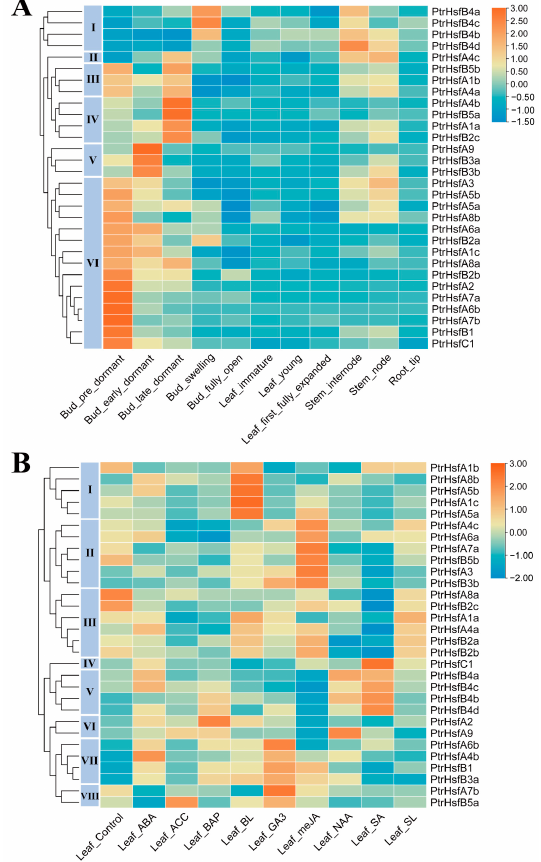
Figure 8. Poplar HSF gene expression analysis in different tissues and hormonal responses. ( A ) Heatmap of HSF gene expression in different tissues of poplar. ( B ) Heatmap of HSF gene expression in response to different phytohormones in poplar